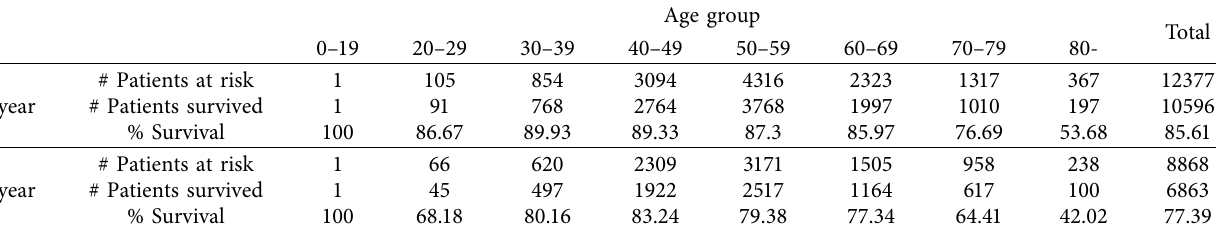
Table 9: Survival rates for female breast cancer in urban Shenyang in 2008–2017.